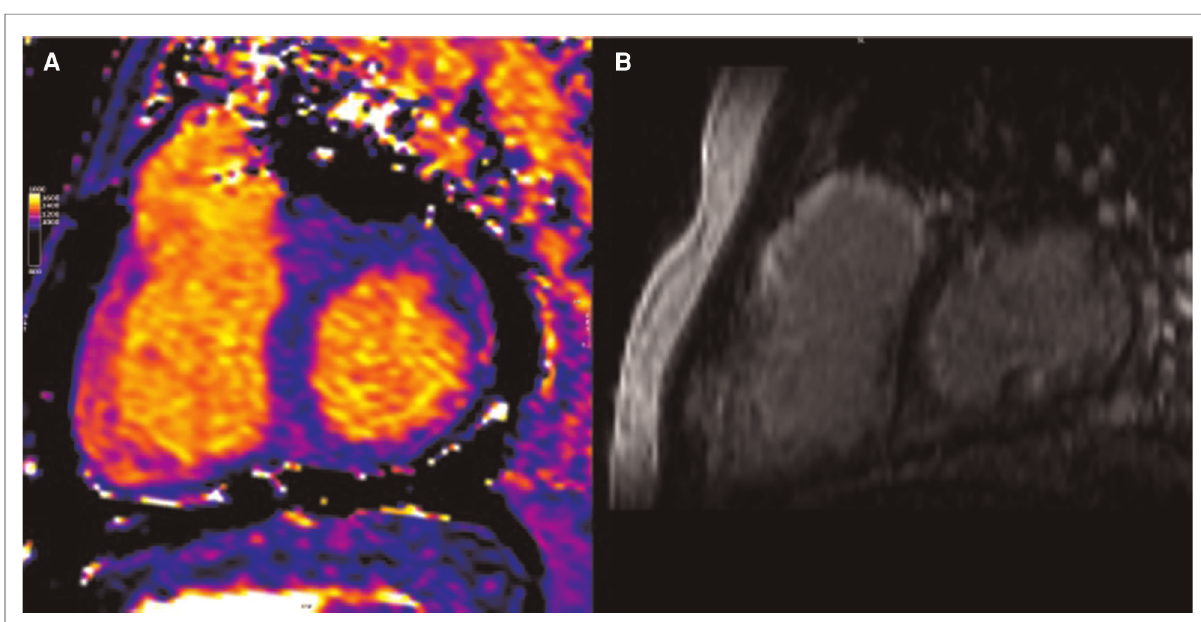
FIGURE 2 CMR of patient with repaired tetralogy of Fallot. ( A ) Precontrast T1 mapping of 1,091 ms (normal range of 950 – 1,050 ms) ( B ) Extent LGE, especially anterior wall of RVOT and anterior wall of